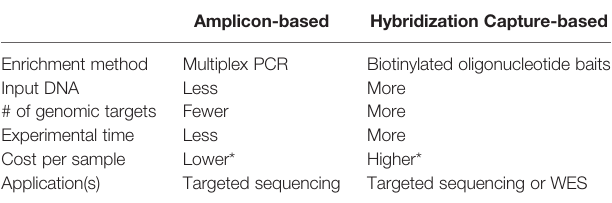
TABLE 3 | Comparison of NGS approaches for molecular pro fi ling of aldosterone-producing adrenal cortical lesions. Amplicon-based Hybridization Capture-based Enrichment